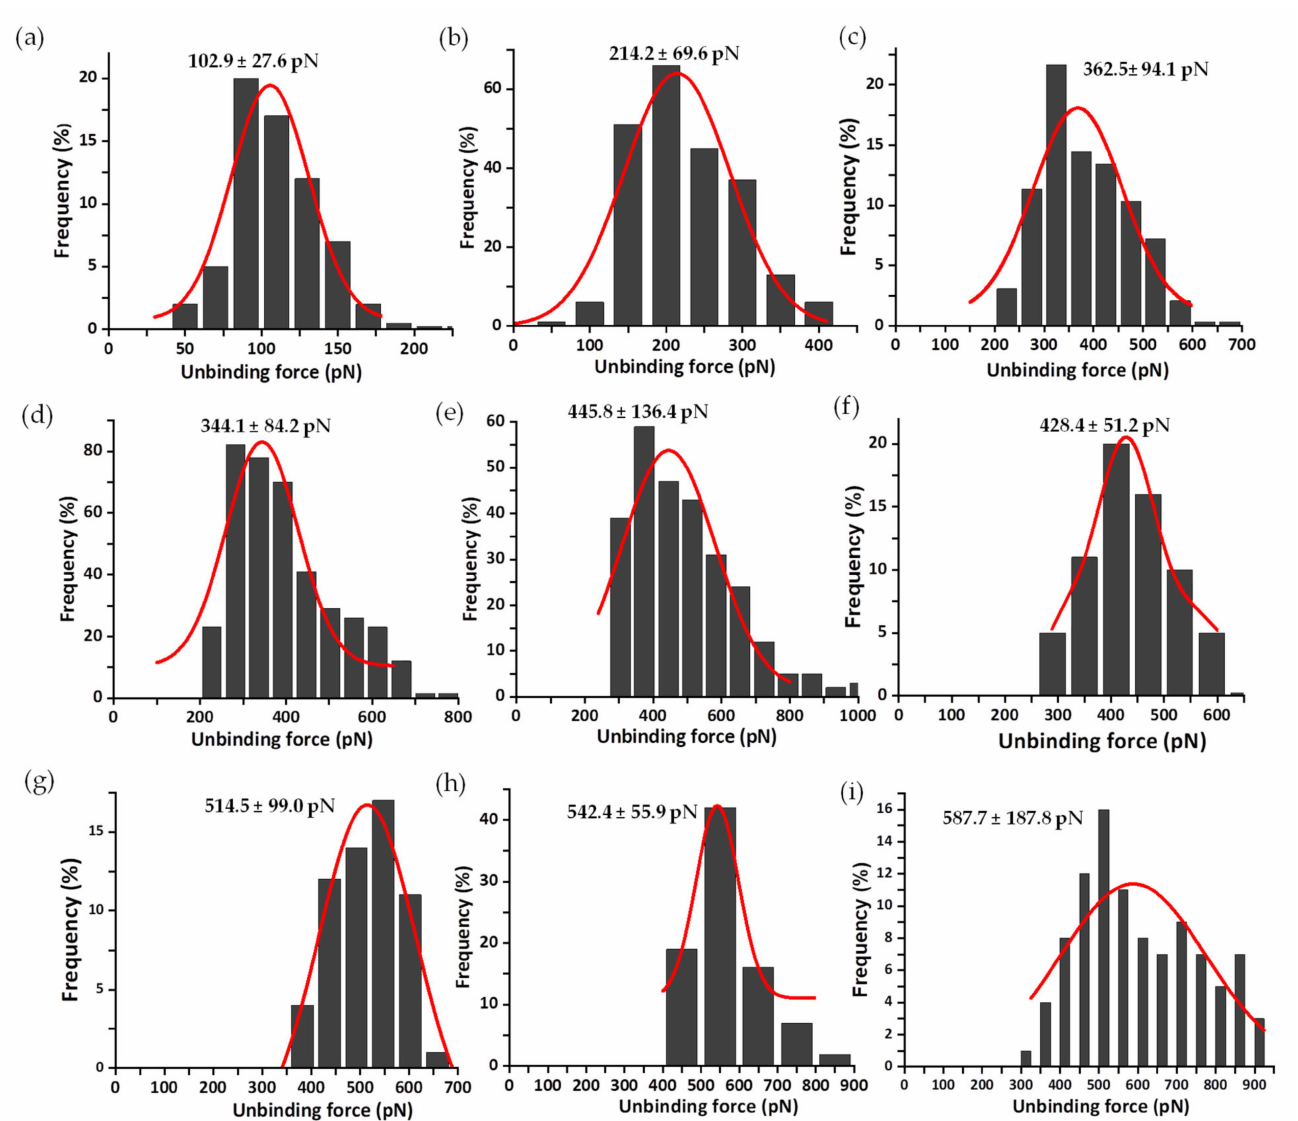
Figure 6. Force histogram distributions for WT AnFNR ox :NADP + complexes. Data force obtained operating at R values of 6 ( a ), 13 ( b ), 20 ( c ), 25 ( d ), 30 ( e ), 40 ( f ), 60 ( g ), 65 ( h ), and 78 ( i ) nN/s. The width of the bars varies in each case, depending on the optimum fit, with the Gaussian function shown in red. Data from R 10 nN/s were also measured, but are shown below. Each fitting provides the most probable unbinding force corresponding to the rupture of a single complex and is shown on the corresponding